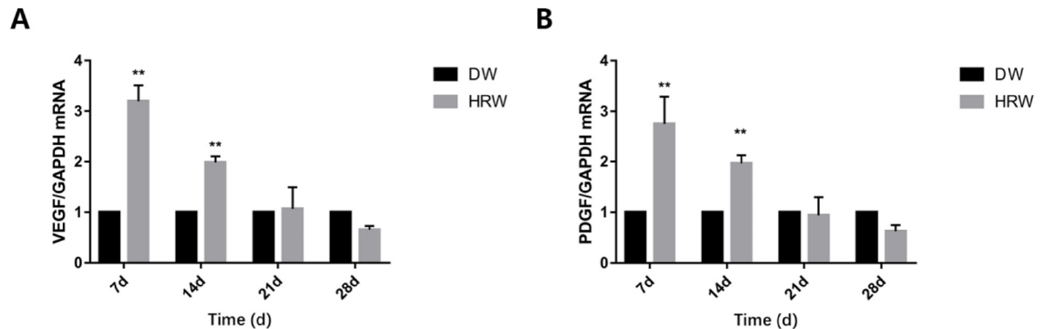
Figure 8. Relative ( A ) VEGF and ( B ) PDGF mRNA levels were measured by TaqMan real-time PCR. ** p < 0.01.